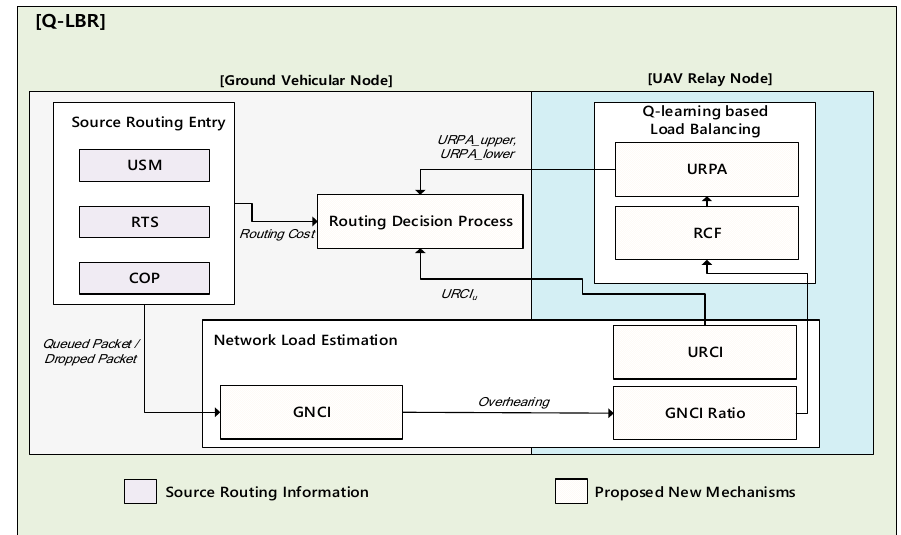
Figure 2. Q-learning based load balancing (Q-LBR) framework.